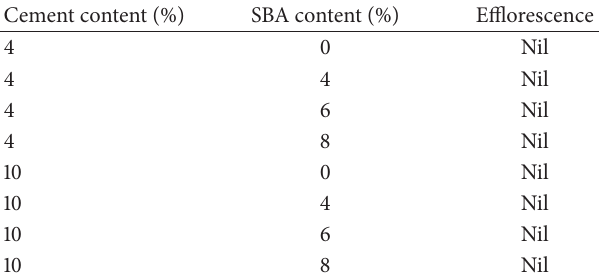
Table 3: Efflorescence of stabilized